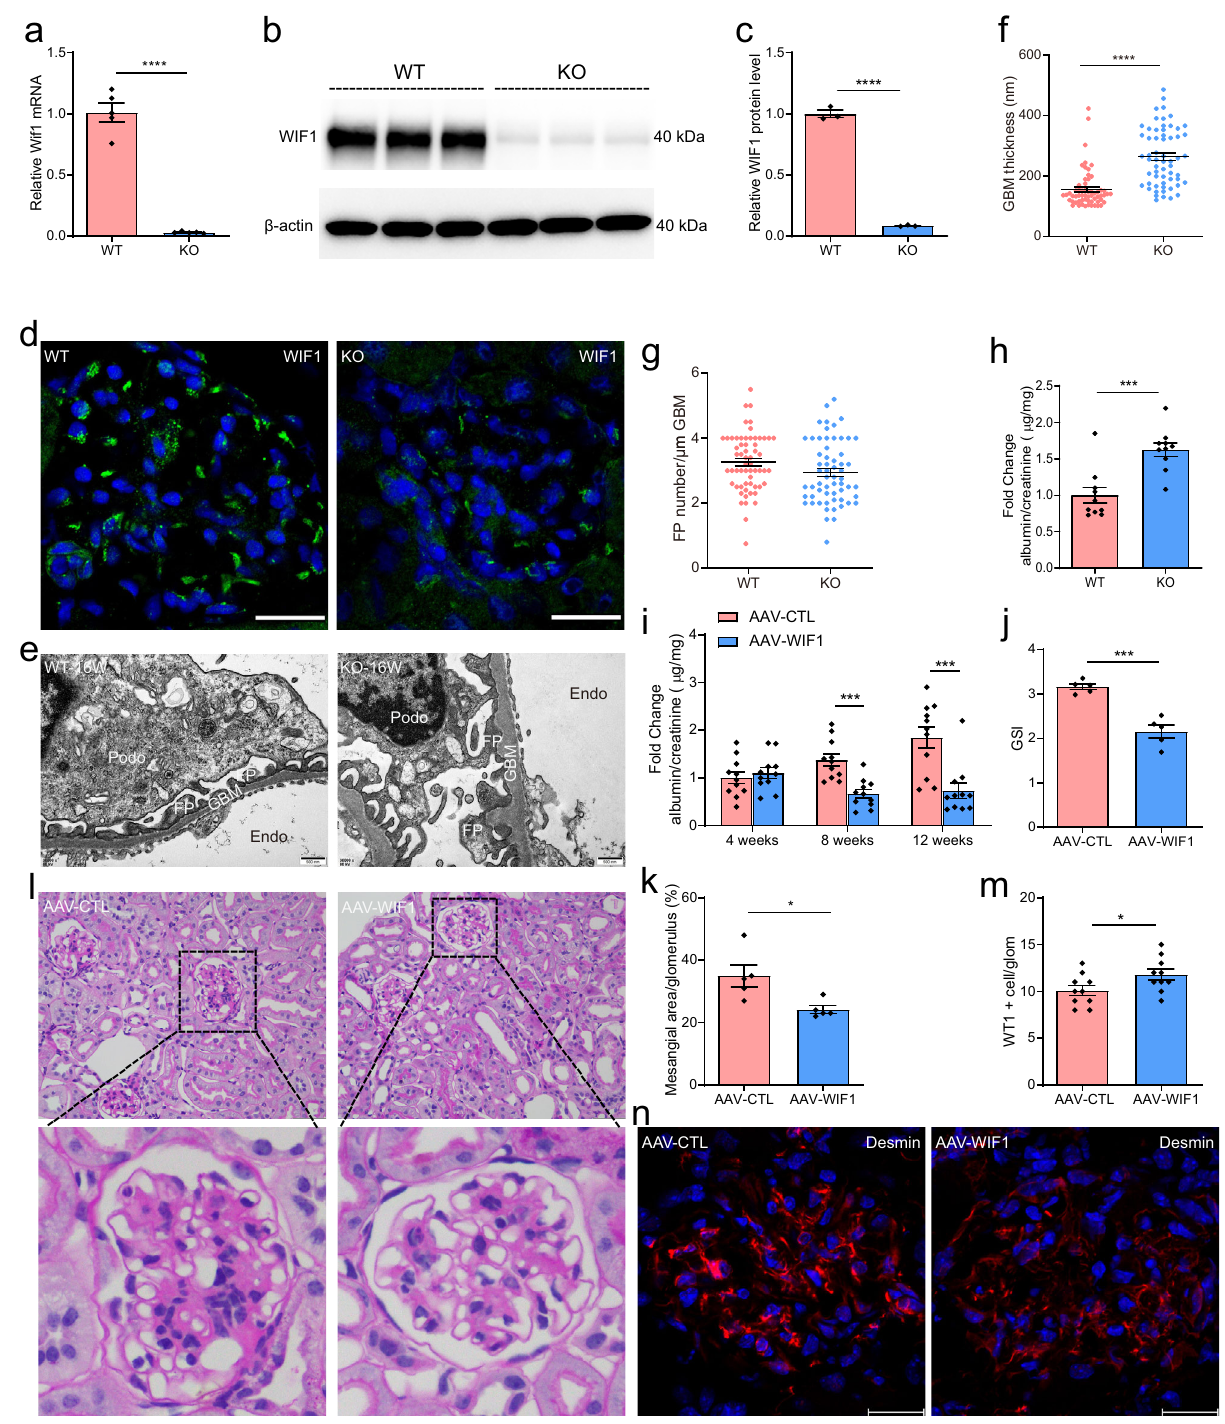
Systemic delivery of WIF1 attenuates DN and UUO-induced renal fi brosis . Does exogenous WIF1 hold promise as a ther- apeutic agent for injured kidney? We tested the therapeutic potential of systemic delivery of WIF1 in type 1 diabetic mice. Treatment of diabetic mice with AAV-WIF1 signi fi cantly atte- nuated albuminuria by 12 weeks (Fig. 7a). Although there was some variation from mouse to mouse in these functional studies, the results of three independent experiments suggested that sys- temic delivery of WIF1 alleviated albuminuria in diabetic mice. The degree of glomerulosclerosis was also less severe in the WIF1